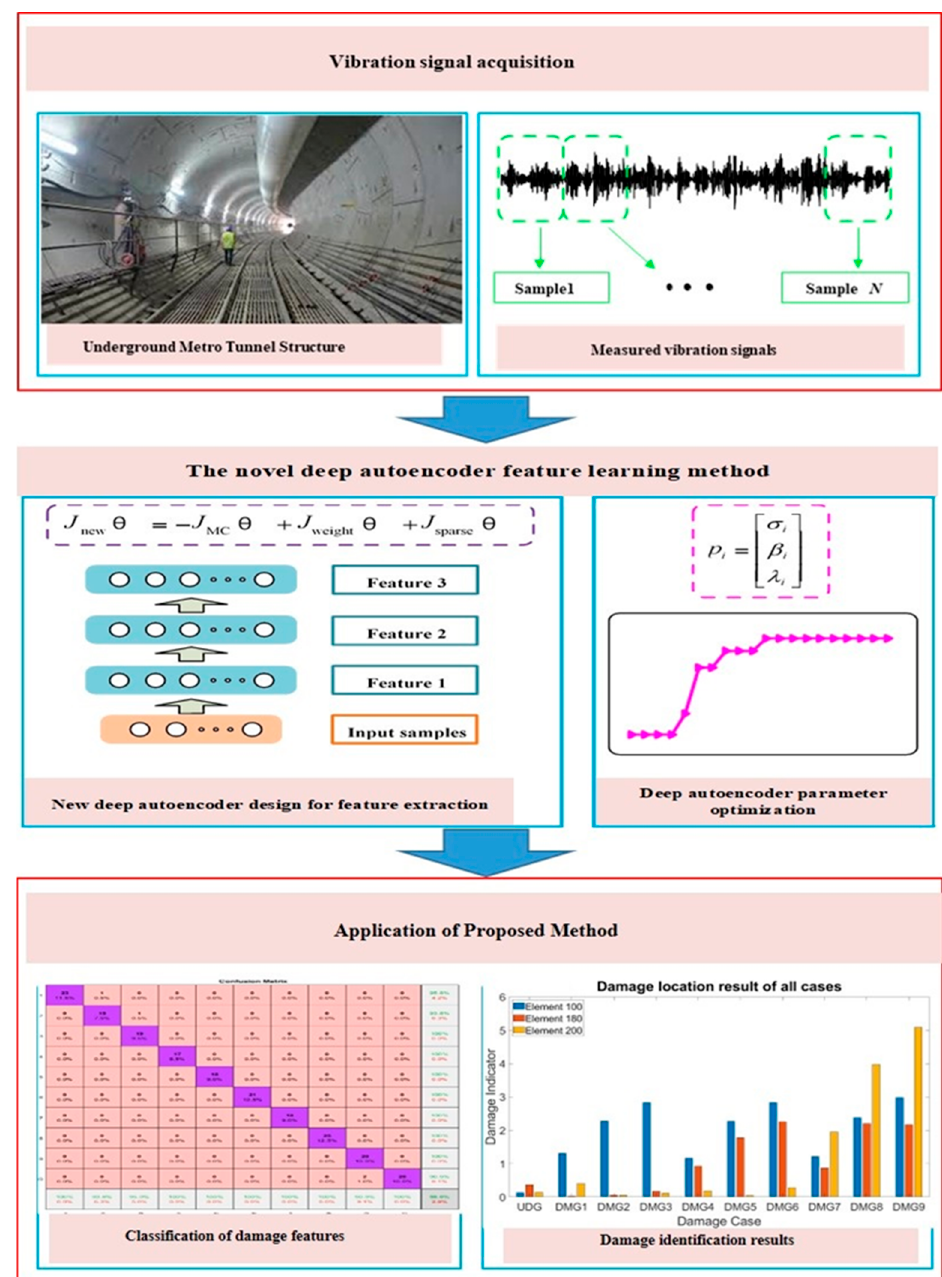
Figure 2. Frame of proposed approach based on auto encoder